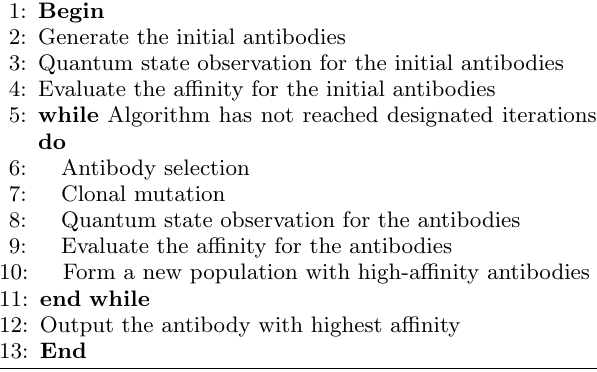
Algorithm 1 The QICEA based energy efficient duty cycle